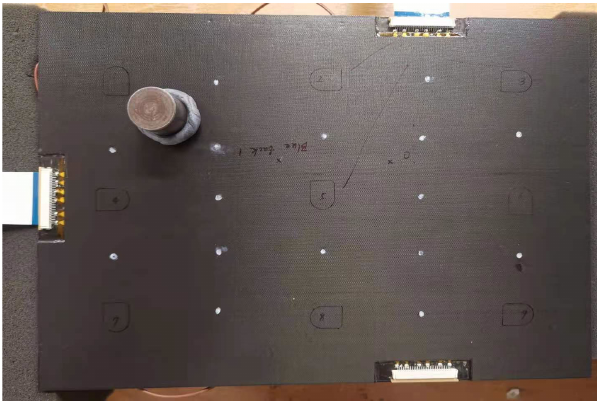
Figure 10. Photo of the surface ‐ mounted artificial damage on the surface of the opposite side of the PZT transducers for the 2 mm thick panel.